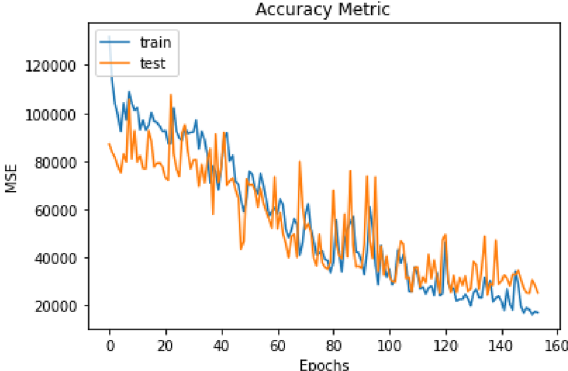
Figure 3. Training rounds compared to testing in Huh7 images. In orange, the test line is observed, and in blue, the training. The MSE value decreases (y-axis) after each training round (x-axis).